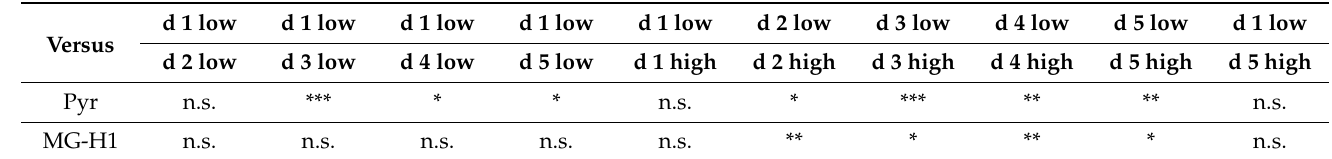
Table 2. Statistical significance (paired t-test) during high versus low MRP diet with the significance